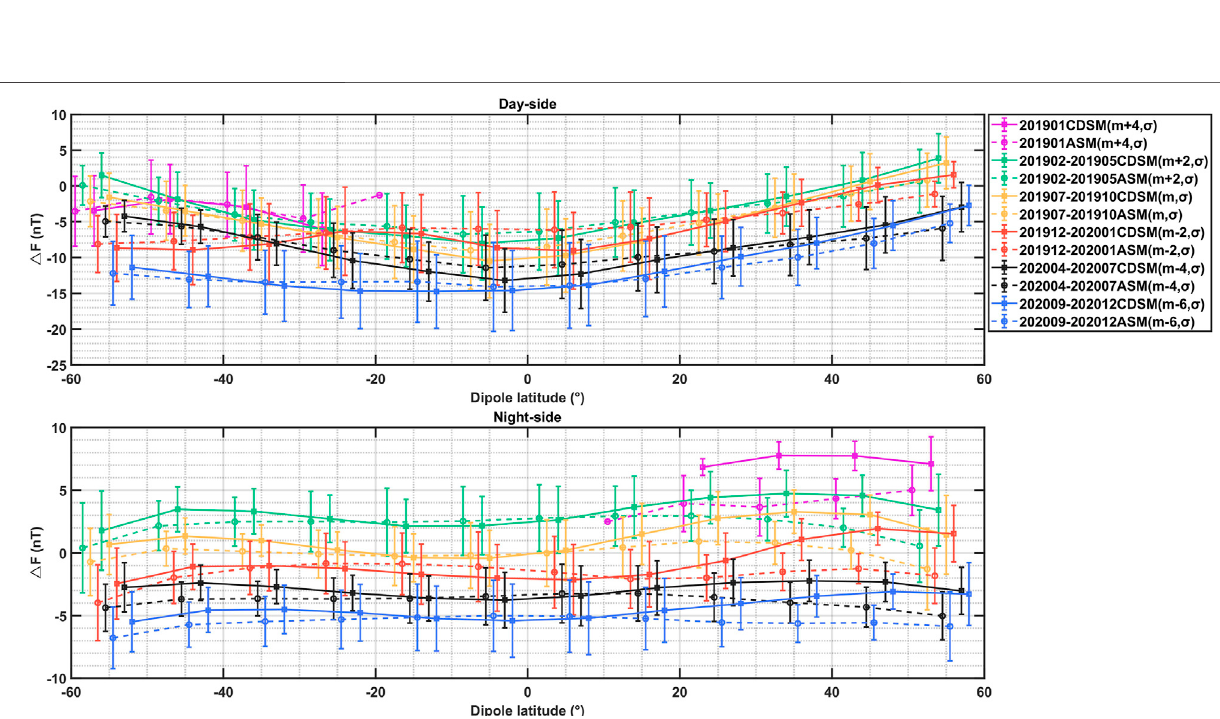
Frontiers in Earth Science |